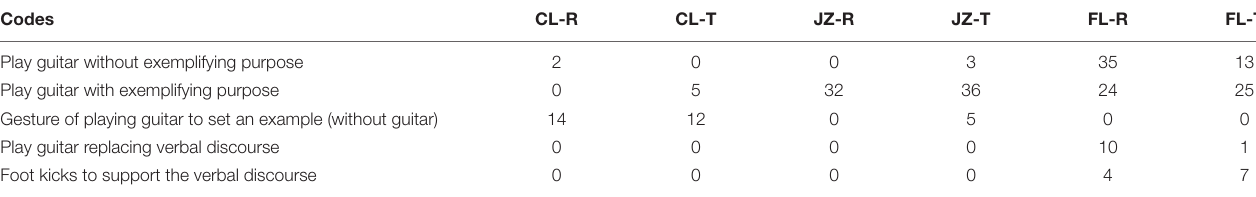
TABLE 1 | Frequency of appearance of gestures that accompany verbal speech in three learning cultures.